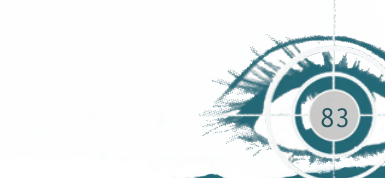
The South African Optometrist